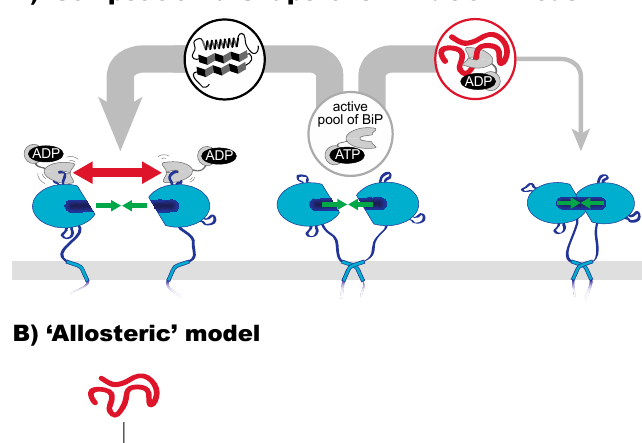
nature of sensing, it remains challenging to assess their relevance in vivo [97,99,100].